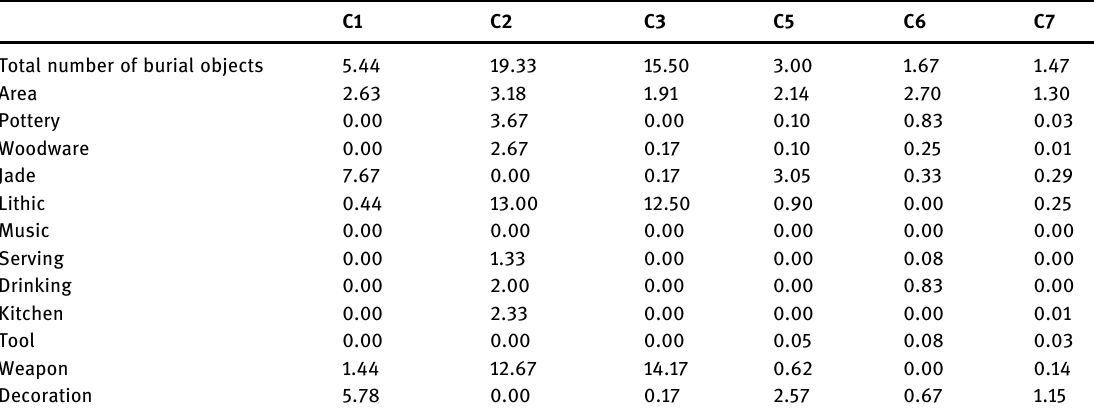
Table 6: Averages of the selected burial variables in the subgroups of group C C1 C2 C3 C5 C6 C7 Total number of burial objects